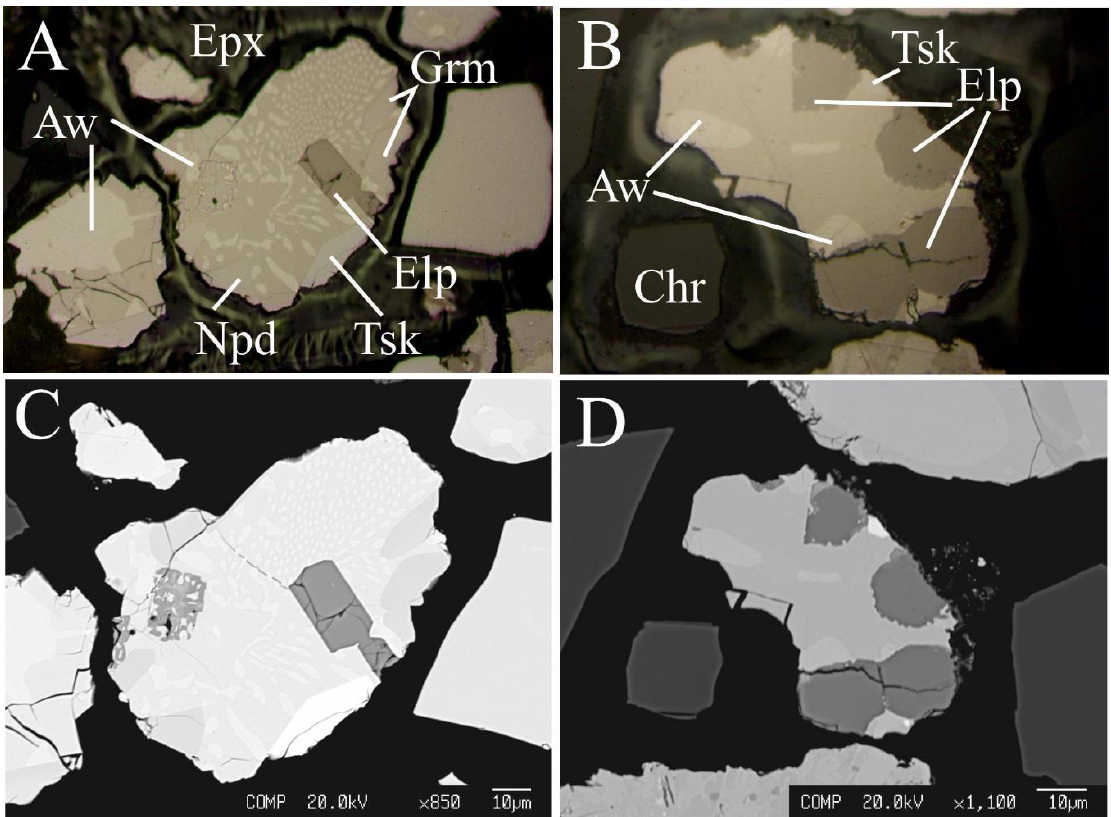
Figure 2. Digital image in reflected plane polarized light ( A , B ) and back-scattered electron image ( C , D ) showing eliopoulosite from the chromitite of Agios Stefanos. Abbreviations: Elp = eliopoulosite, Grm = grammatikopoulosite, Tsk = tsikourasite, Aw = awaruite, Npd = nickelphosphide, Chr = chromite, Epx = epoxy. Table 2. Reflectance values of eliopoulosite, those required by the Commission on Ore Mineralogy (COM) are given in